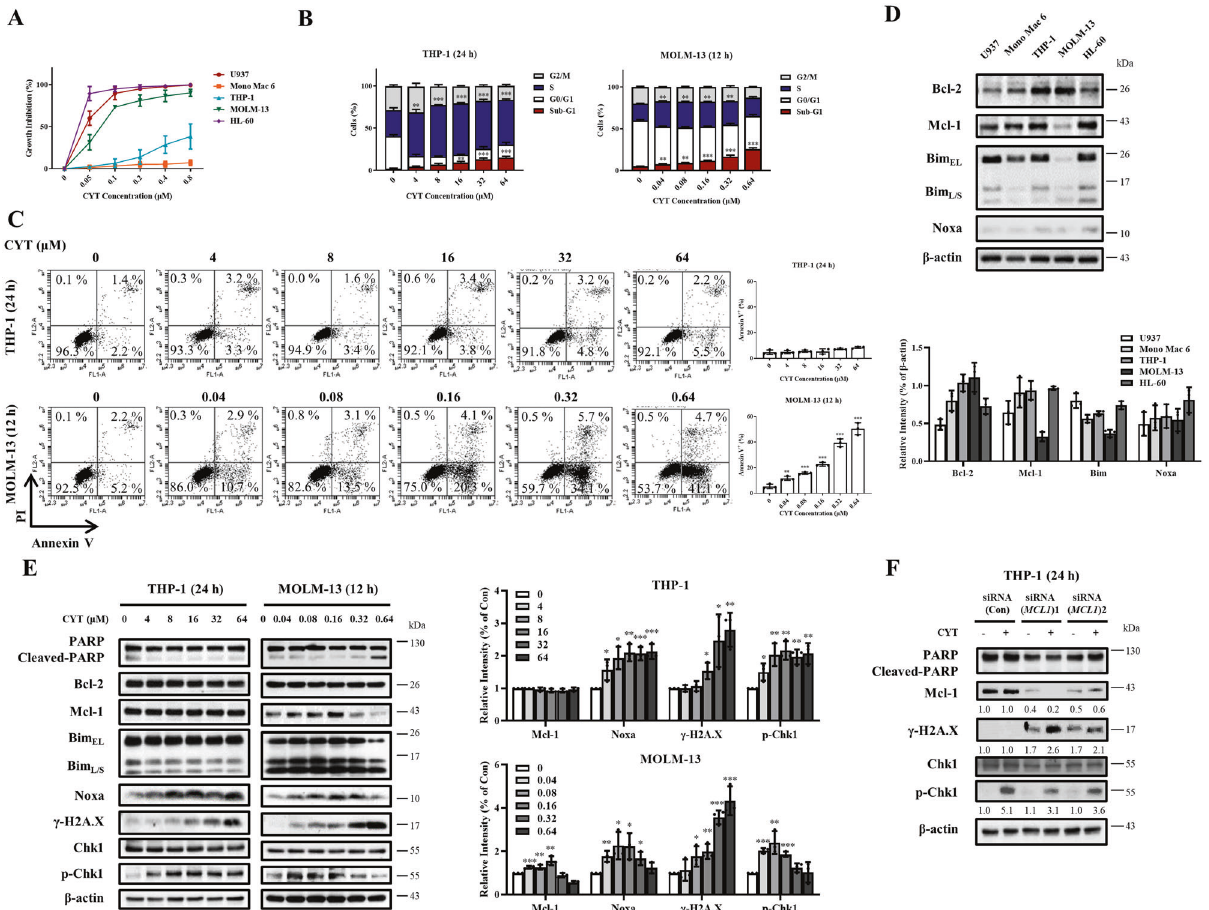
Fig. 1 Mcl-1 levels in fl uence cytarabine (CYT)-induced growth inhibition and DNA damage in AML cells. A Five AML cell lines were treated with 0.05 – 0.8 μ M cytarabine for 72 h. Cell growth inhibition was measured by counting cell number and compared to the untreated group. B THP-1 and MOLM-13 cells were treated with cytarabine at the indicated concentrations and times. Cell cycle distribution assessed by FACS after PI staining. C Apoptotic cells determined by FACS with staining of Annexin V/PI. D Basal levels of Mcl-1, Bcl-2, Bim, and Noxa in fi ve AML cell lines. E Relative levels of the indicated proteins of THP-1 and MOLM-13 cells after treatment with cytarabine determined by Western blotting. F THP-1 cells were transfected with two pairs of MCL1 siRNAs for 24 h, then treated with 8 μ M cytarabine for 24 h, and the levels of γ -H2A.X and p-Chk1 were determined by Western blotting. The column graphs are the mean ± SD of three independent experiments. * P < 0.05; ** P < 0.01; *** P < 0.001 comparing to the control group by t